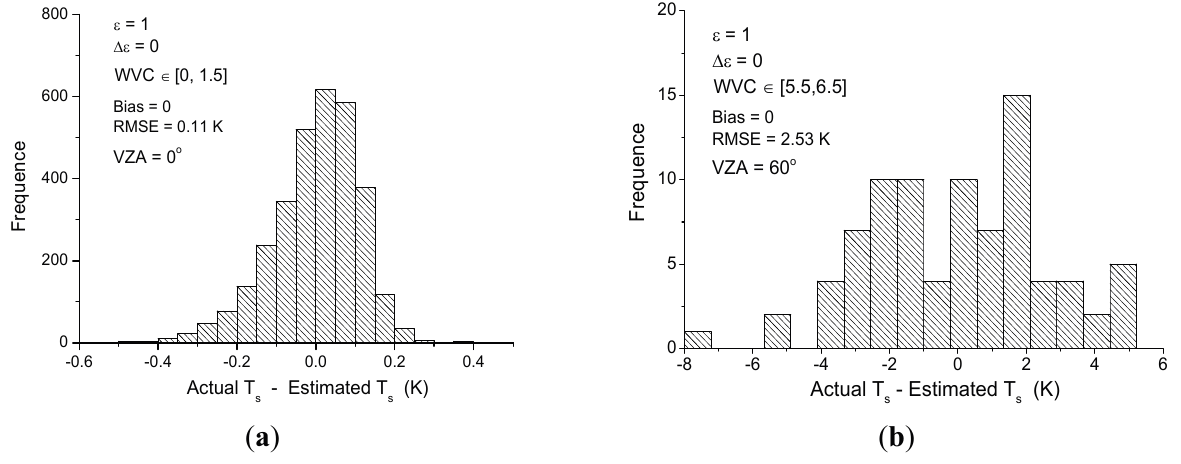
and the (cid:1846) estimated using (cid:3046) (cid:3046)